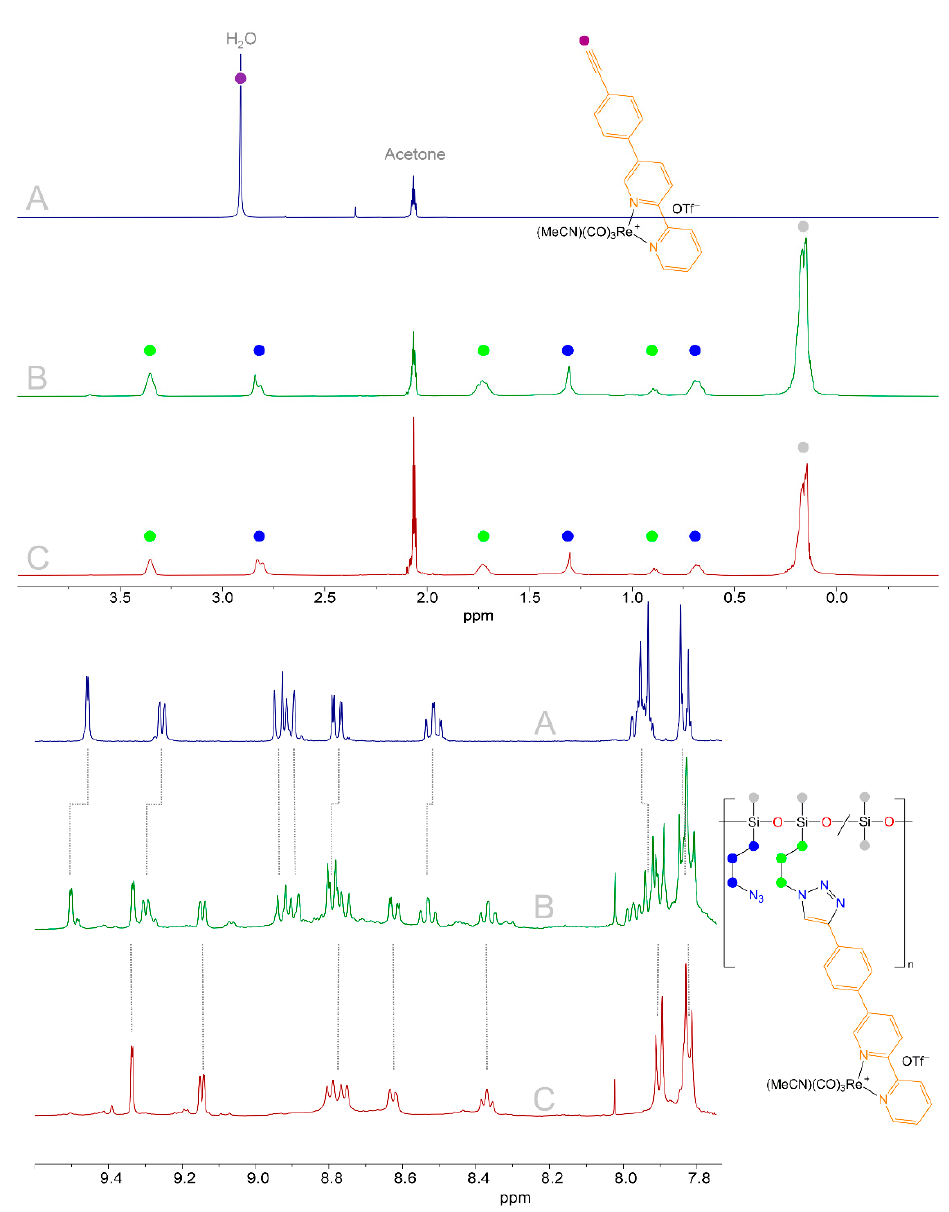
Figure 2. Aliphatic (top) and aromatic (bottom) regions of 1 H NMR spectra (acetone-d 6 , r.t.): ( A ) the initial Re1 complex; ( B ) reaction mixture after 2-day reaction; ( C ) reaction mixture after 5-day